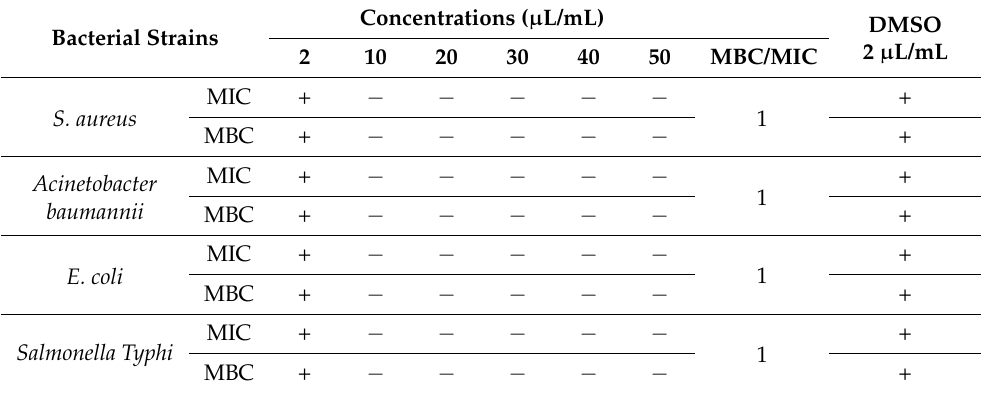
Table 5. MIC and MBC of C. ladanifer essential oil against selected bacterial strains. Bacterial